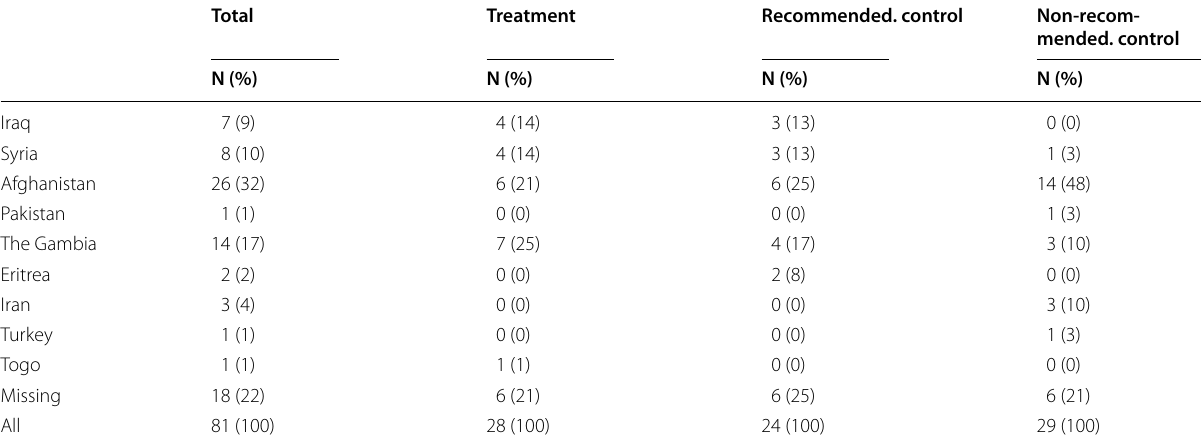
Table 3 Country of birth across groups